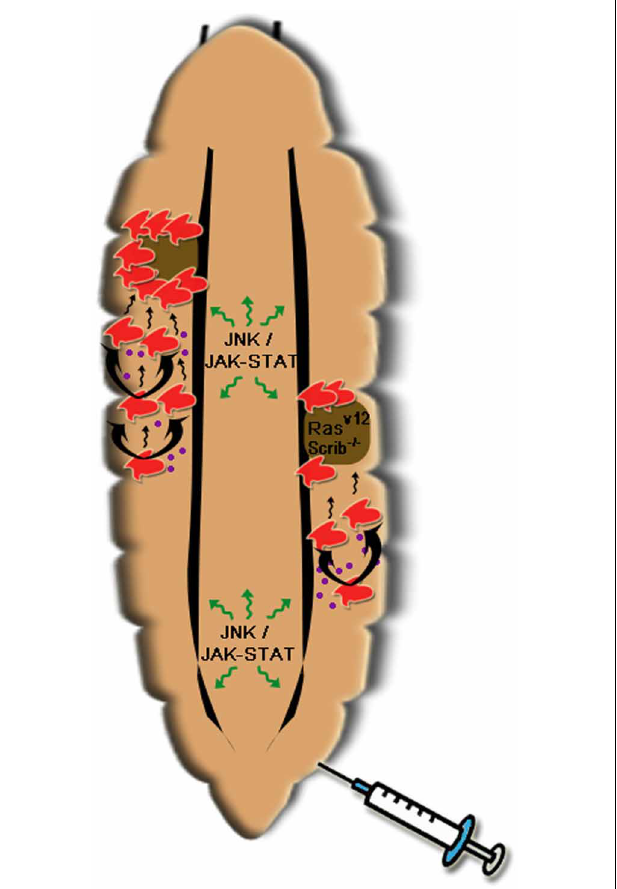
FIGURE 3 | A simple illustration of roles of haemocytes in the Drosophila tumor model. Both tumor (Ras v12 Scrib − / − ) and wounding (as illustrated by a needle) can trigger proliferation of circulating haemocytes in the larva. This is mediated by cytokines (most probably Upd 1–3 shown in purple dots) induced by JNK signaling in response to wounding or the invasive tumor itself. In responses to the cytokines, JAK/STAT signaling in haemocytes or the fat body (not shown) can be activated and thus can further amplify the cytokine expression to promote haemocyte proliferation. Meanwhile disruption of basal membrane in the tumor attracts the adherent of haemocytes and limits the tumor growth perhaps by the synthesis of Drosophila TNF α , Eiger. This cartoon delineates that a step wise proliferation of haemocytes induced by wounding can be used to counter tumor growth. Modeling of these two processes (tumor growth and inflammation) in the Drosophila larva points out the potential beneficial effect that systemic inflammation can exert on tumorigenesis and will open more avenues for the basic research on innate immunity in particular macrophages’ role in human tumor (see text for more